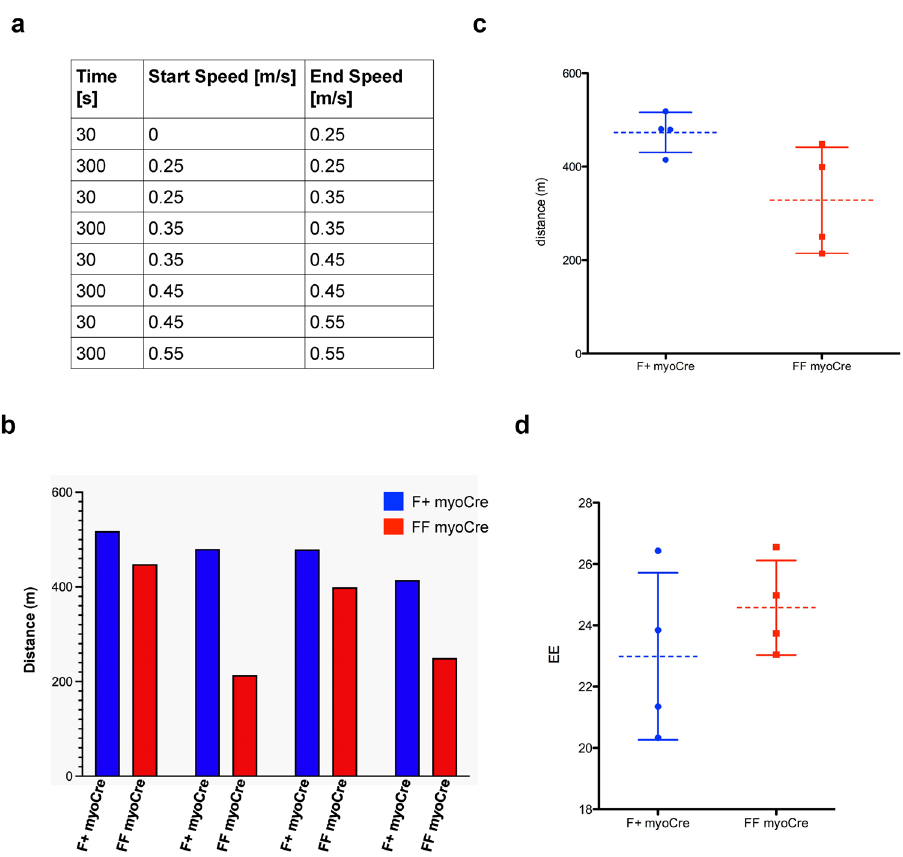
Fig. 6 | SIRT6 deletion in muscle does not signi fi cantly affect muscle perfor- mance in vivo. The experiment was performed on 4 mice per genotype. a Table summarizingthesettingforthemuscleperformanceexperiment.Inbrief,miceran up to 300s at each speed. 30s were allowed to increase the speed between the 300s intervals. b The histogram represents the distance each pair of mice (F+